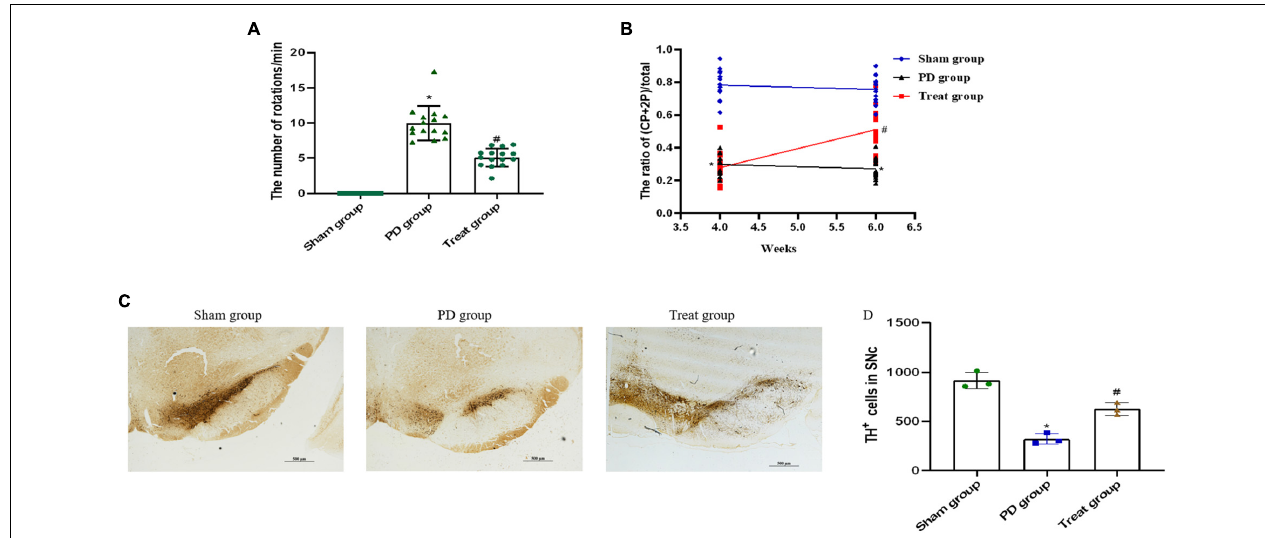
FIGURE 1 | ALA ameliorates motor behavior and prevents DA neuron loss in the SN of PD rat models. ALA ameliorates apomorphine-induced rotation behavior (A) and fine motor activity in the 6-OHDA-induced rat model of PD (B) . Data were expressed as the means ± SD ( n = 15/group) and analyzed by one-way ANOVA. The immunohistochemical staining of TH-positive neurons in the SN. Scale bar, 500 µ m (C) . The number of TH-positive cells was averaged from three non-overlapped fields per slide of the SNpc region. (D) Quantification of TH-positive neurons in the SN. Data were presented as the mean ± SD ( n = 3). Statistical significance: * P < 0.01 compared with the sham group; # P < 0.01 compared with the PD group by